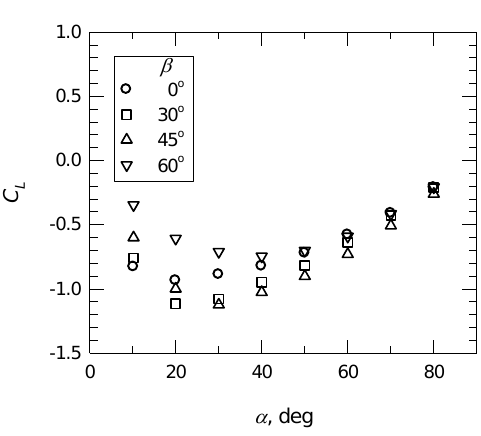
Figure 10. Lift coe ffi cient. Figure 10. Lift coefficient. Figure 10. Lift coefficient.